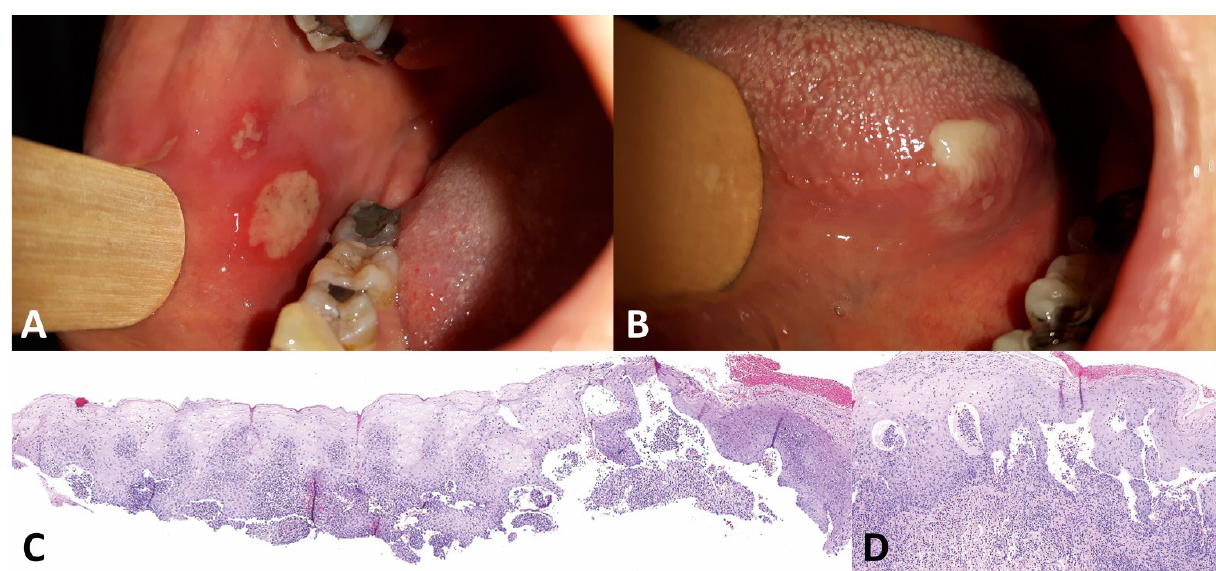
Fig. 1. (A) Primary lesion of the right buccal mucosa evaluated as a recurrence of aphthous stomatitis treated with local cortico- steroid and laser therapy. (B) Sloughing blister at the left tongue margin. The same lesions appeared on the left buccal mucosa and labial mucosa of the lower lip. (C) Whole–mount of the lesion: hyperplastic epithelium with subepidermal clefting/ blisters and dense inflammatory infiltrate. (D) Close-up of the area corresponding to the finding of coexisting intraepidermal vesicles and subepidermal clefting with both neutrophils and eosinophils.